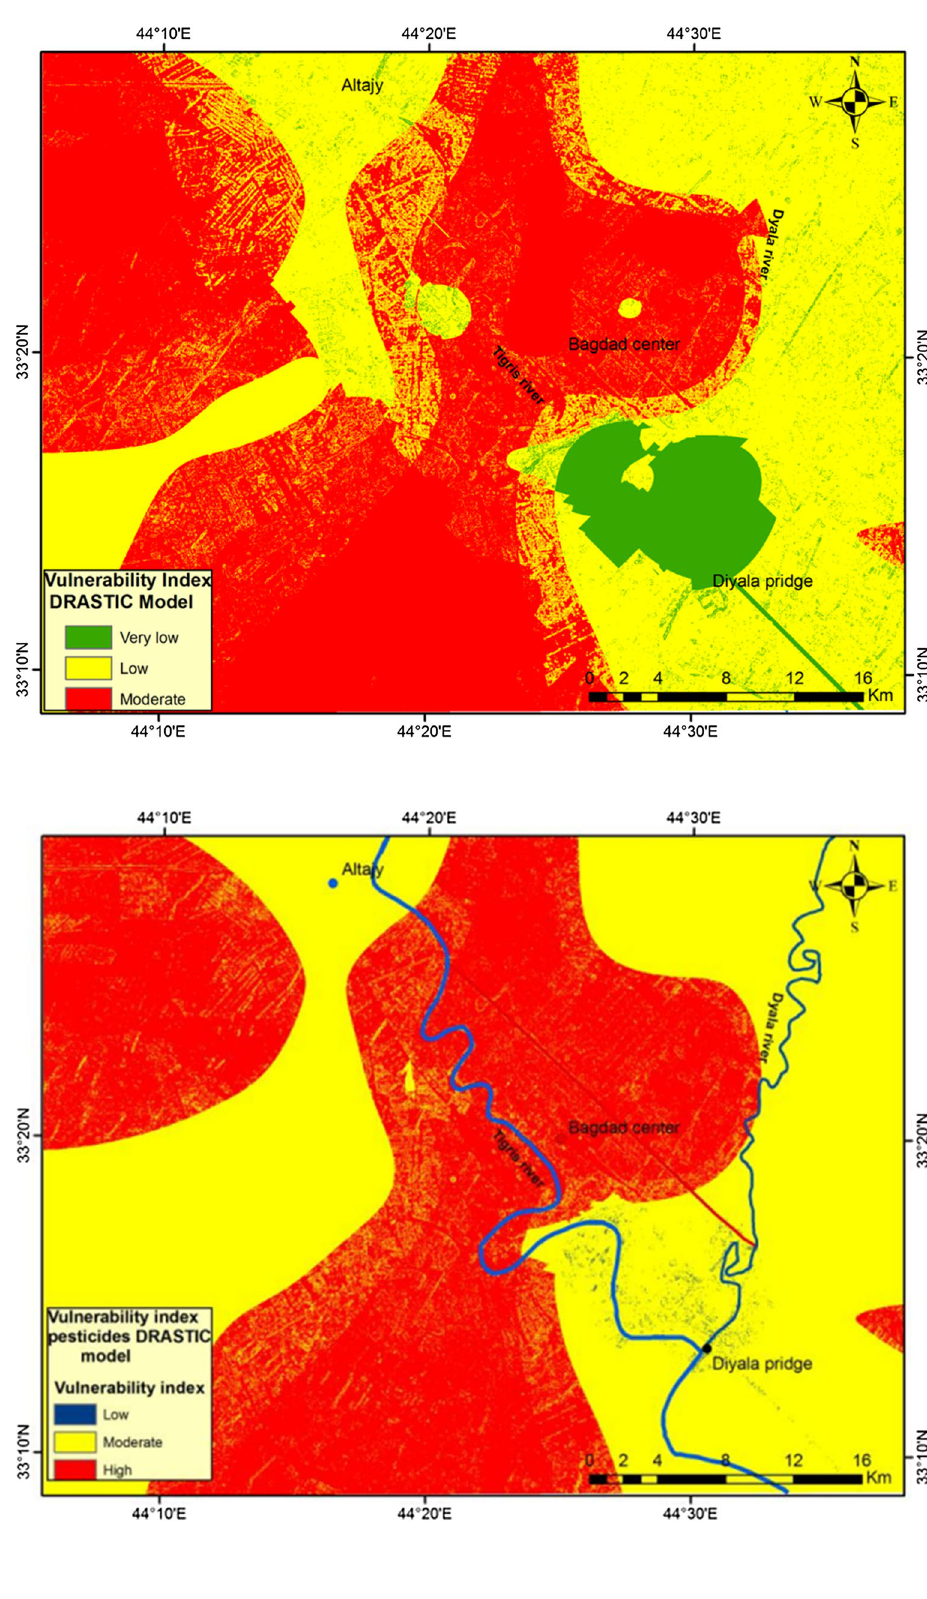
(Standard DRASTIC model) map of the study area